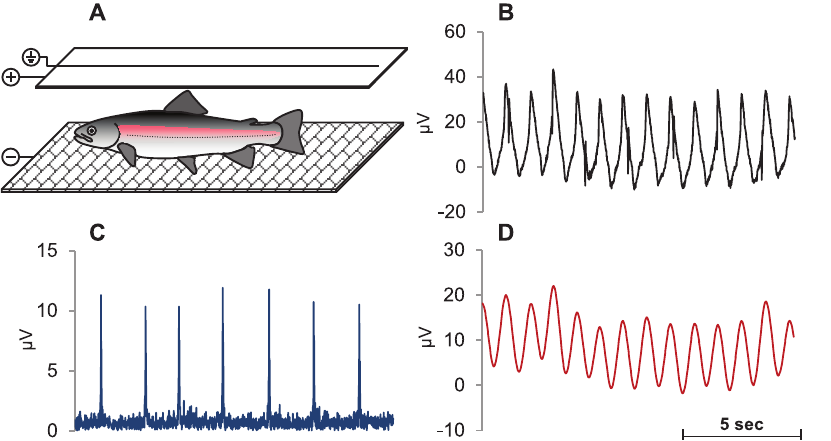
Figure 2. Non-invasive method for cardioventilatory recordings in fresh water. (A) Schematic illustration of Rainbow trout (Oncorhynchus mykiss) in the wireless recording system. (B) Example of the raw bioelectrical potential signal. (C) Example of high-pass filtered raw signal with a cut- off frequency applied at 10 Hz to identify individual heartbeats. (D) Example of low-pass filtered raw signal with a cut-off frequency at 100 Hz and smoothed with a triangular window of 201 sample points to identify ventilatory movements.